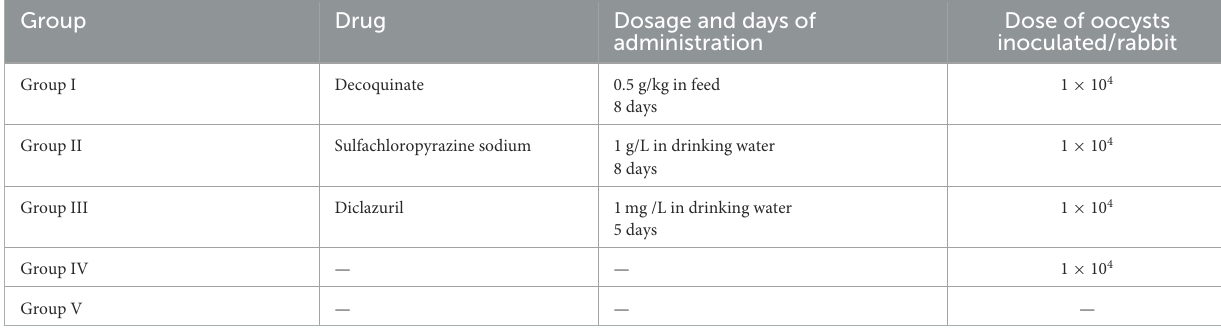
Dose of oocysts administration